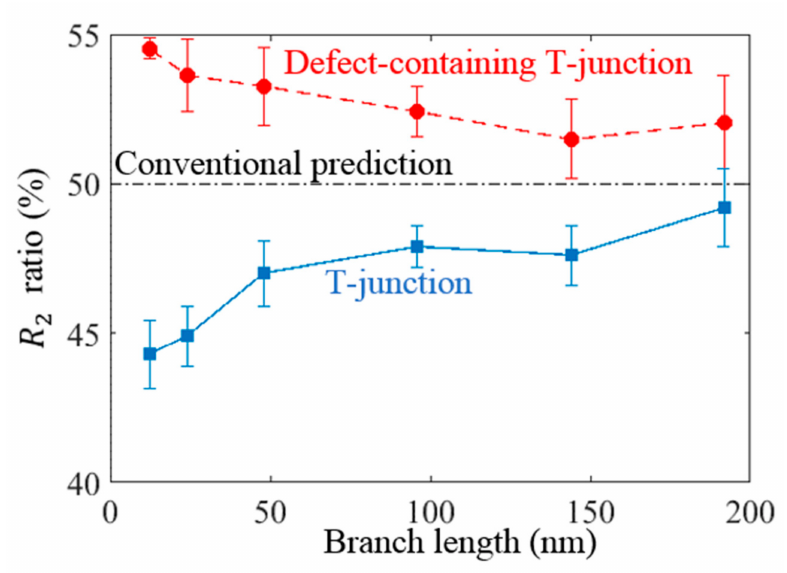
Figure 9. Branch length dependence of the heat current ratio in branch 2 of the branched CNT with the T-junction and defect-containing